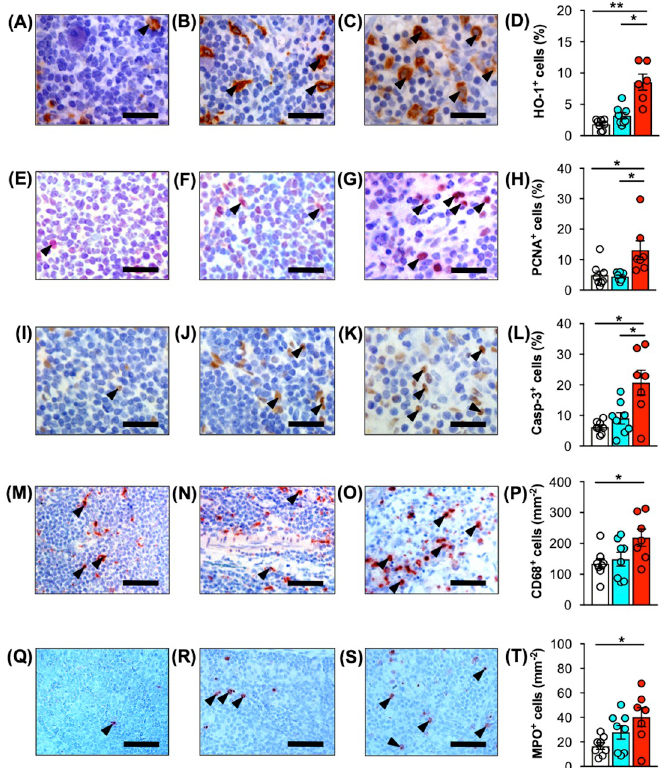
(%). E-H Immunohistochemical detection of PCNA + cells (arrowheads) in control ( E ), IR-45 ( F ) and IR-120 ( G) lymph nodes. H Quantitative analysis of PCNA + cells (%). I-L Immunohistochemical detection of Casp-3 + cells (arrowheads) in control ( I ), IR-45 ( J ) and IR-120 ( K ) lymph nodes. L Quantitative analysis of Casp-3 + cells (%). M-P Immunohistochemical detection of CD68 + macrophages (arrowheads) in control ( M ), IR-45 ( N ) and IR-120 ( O ) lymph nodes. P Quantitative analysis of CD68 + cells (mm -2 ). Q-T Immunohistochemical detection of MPO + neutrophilic granulocytes (arrowheads) in control ( Q ), IR-45 ( R ) and IR-120 ( S ) lymph nodes. T Quantitative analysis of MPO + cells (mm -2 ). Mean ± SEM, n = 6–8, � P < 0.05, �� P < 0.001. Scale bars: A-C , E-G and I-K = 25 μ m, M-O and Q-S = 50 μ m. Casp-3 = cleaved caspase-3, HO = heme oxygenase, IR = ischemia/reperfusion, MPO